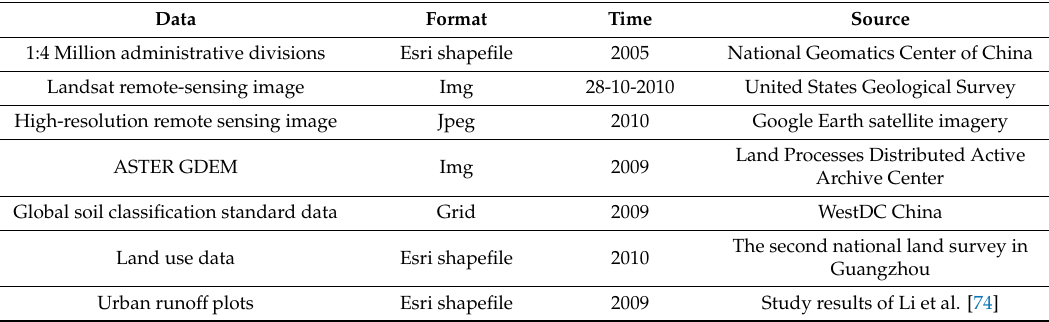
Table 1. Metadata